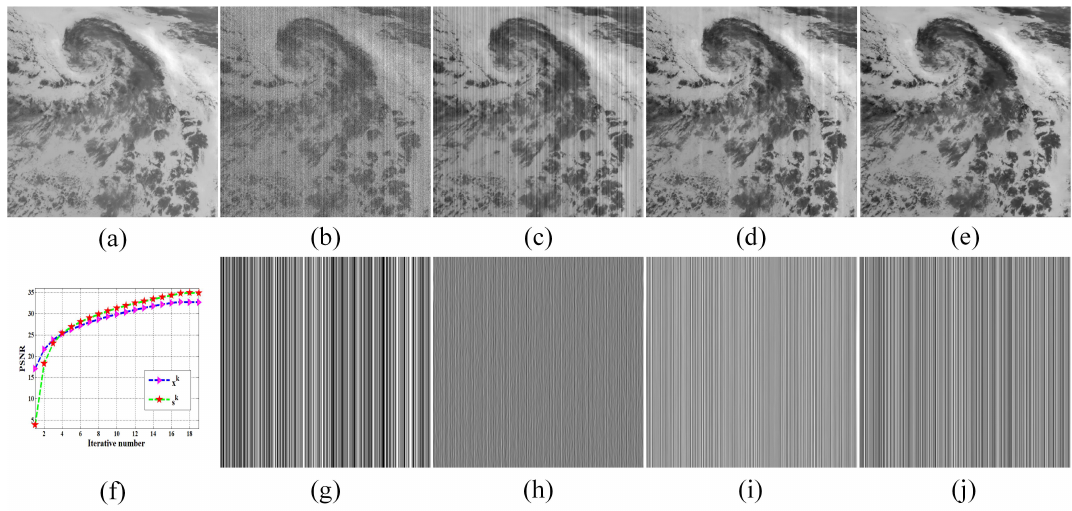
Figure 8. The intermediate results of x k and s k on the STM1 image in Figure 5a at different iterations. Where noise level σ = 30, the proportion P and the intensity I of the non-periodical stripe are respectively 0.4 and 30. ( a ) Ground-truth. ( b ) Degraded STM1 image. ( c – e ) Visual images respectively at the 3rd, 11th, and 21th. ( f ) Convergence curves of x and s . ( g ) Ground-truth stripe. ( h – j ) Visual stripes respectively at the 3rd, 11th, and 21th